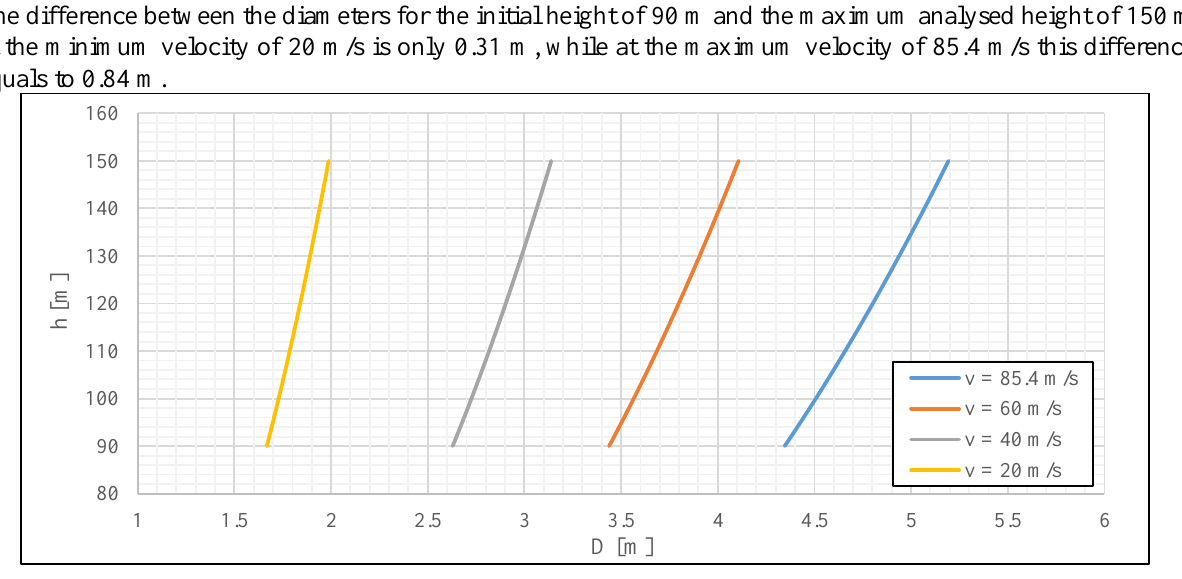
Figure 2. Tower diameter as a function of